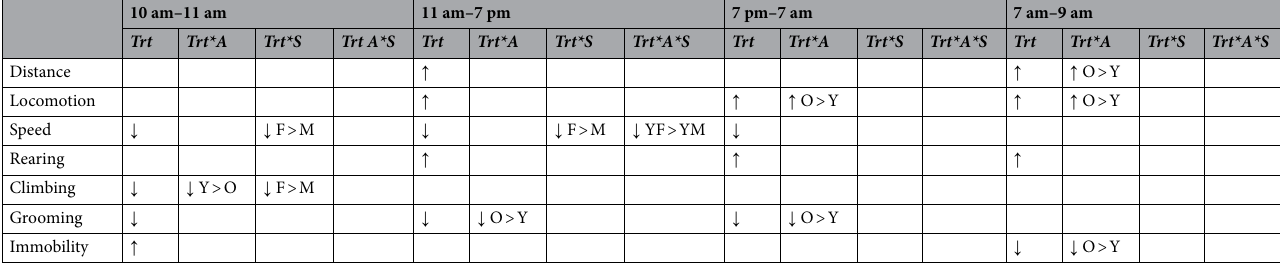
Table 1. Summary of the comparisons between control and HDBI polypharmacy. ↑ , ↓ : increase or decrease in HDBI polypharmacy, compared to control. Y young; O old, M male, F female, Trt indicating the effects of HDBI polypharmacy treatment, Trt*A indicating treatment × age interactions, Trt*S indicating treatment × sex interactions, Trt* A*S indicating treatment × age × sex